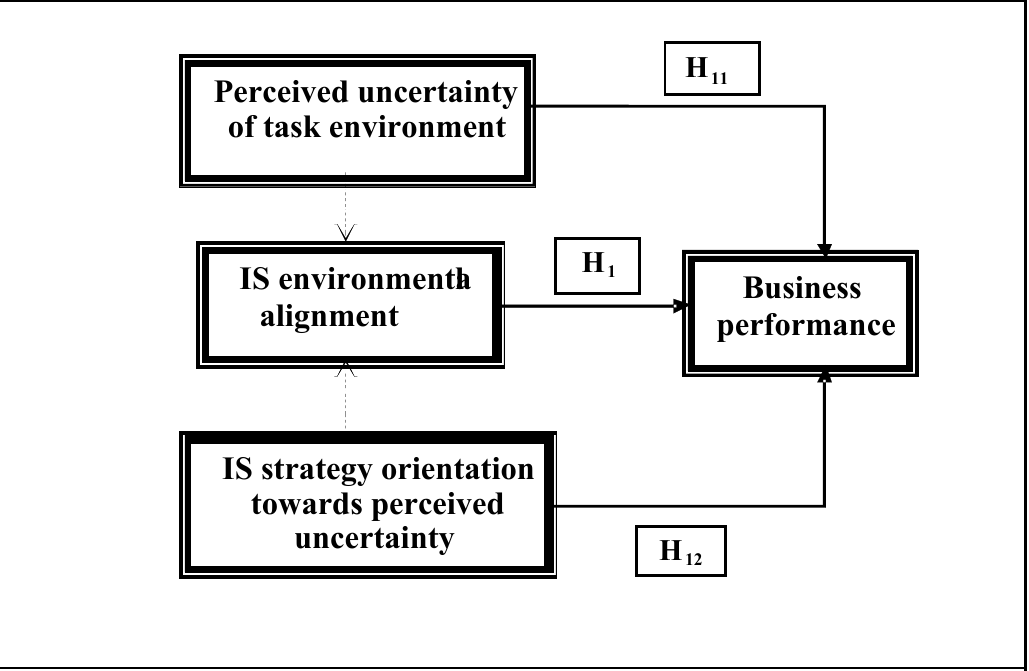
Figure 6: IS environmental alignment model